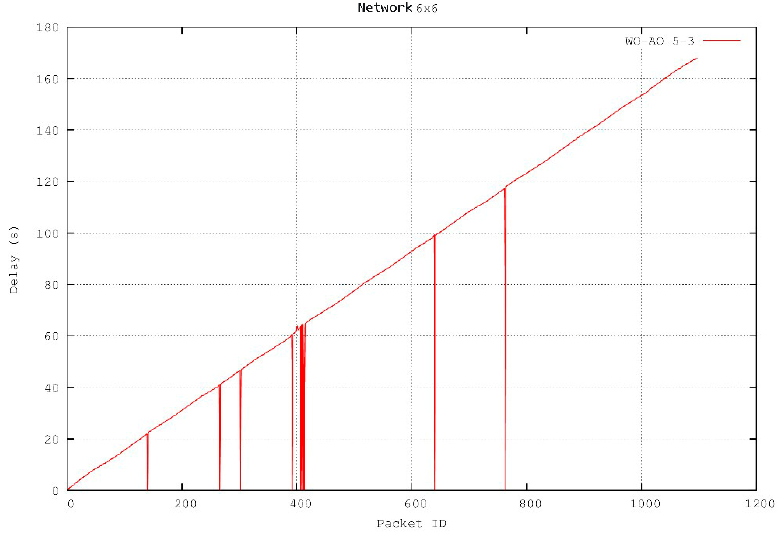
Figure 9. Packet latency.